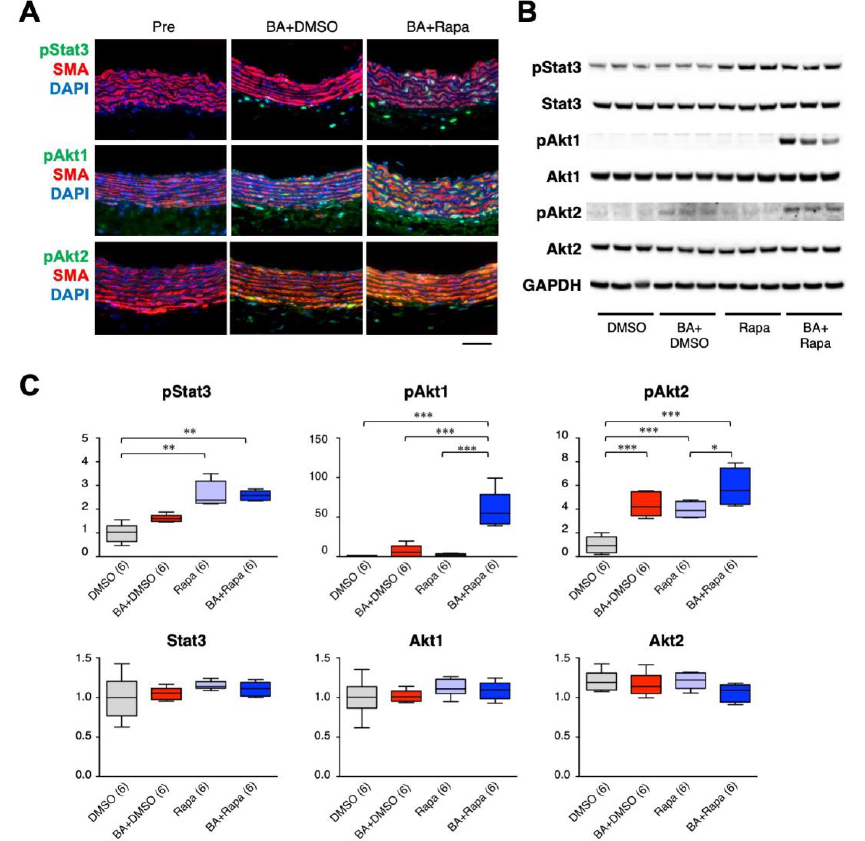
Figure 5. E ff ect of rapamycin on cellular signaling in SMCs. E ff ect of 3 days of BAPN + AngII (BA) and rapamycin on pStat3, pAkt1, and pAkt2 in aortic tissue ( A ) or in SMCs in culture (B, C). (A) Representative immunofluorescence images of triple staining for SMA (red), nuclear DAPI (blue) staining, and pStat3, pAkt1, or pAkt2 (green). Scale bar: 50 µm. ( B ) Representative images of Western blotting for the indicated proteins. Glyceraldehyde-3-phosphate dehydrogenase (GAPDH) served as an internal loading control. ( C ) Quantitative analysis of the indicated proteins. The figures in parentheses indicate the numbers of independent observations. * p < 0.05, ** p < 0.01, *** p < 0.001. Among the multiple experimental groups, all comparisons between two groups were tested and for simplicity only those with statistically significant di ff erences are